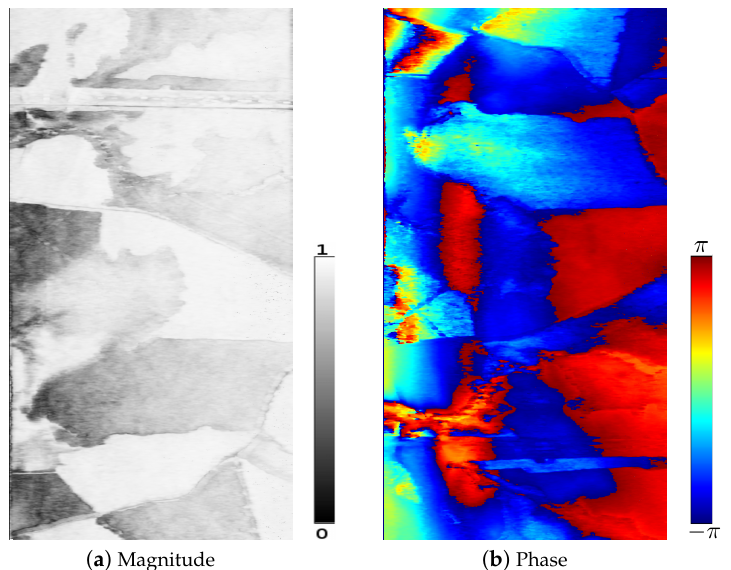
Figure 14. γ opt